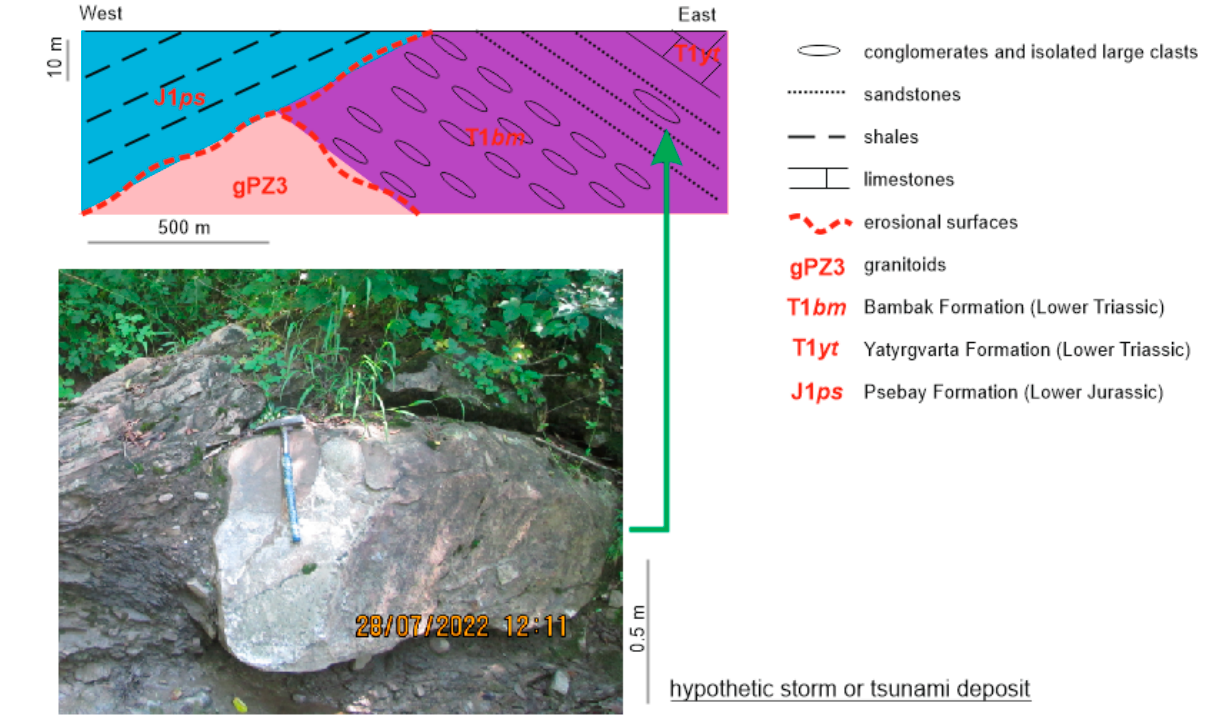
Figure 2. Lowermost Induan strata (Bambak Formation) of the Western Caucasus: simplified cross- section (above) and image of characteristic megaclast in sandstone bed (below) (the image is a part of the larger photograph from [57], and it is re-published with permission of